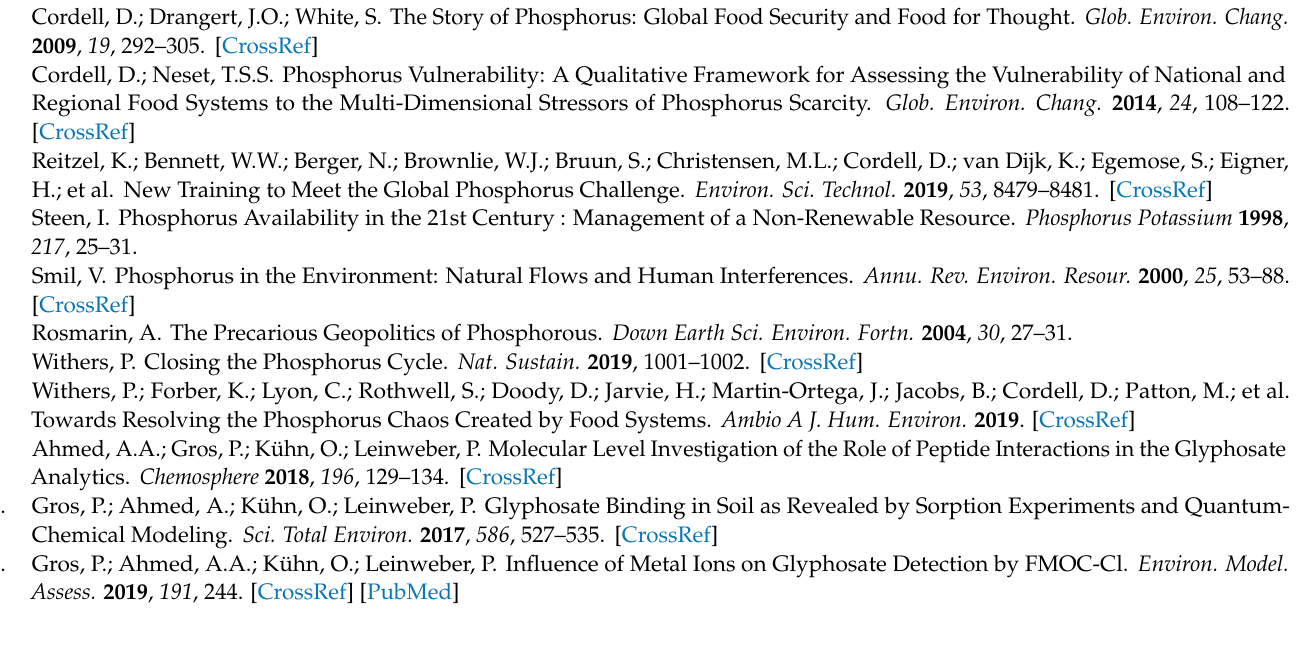
Figure S2: Comparison of GP and IHP spectra with experimental spectra, Figure S3: Initial motifs of IHP and GP, Figure S4: GP BB motif, HBs between GP and surrounding water and water bonded to surface Fe atoms, Figure S5: Pair correlation function for surface Fe atoms and water oxygens, Figure S6: Fe-O p covalent bond lengths along simulation trajectories between 25 and 55 ps, Figure S7: Binding energy of IHP M(1) motif along simulation trajectory between 25 and 55 ps, Figure S8: IR spectra of GP M and B motif cases and IHP M and 3M motif